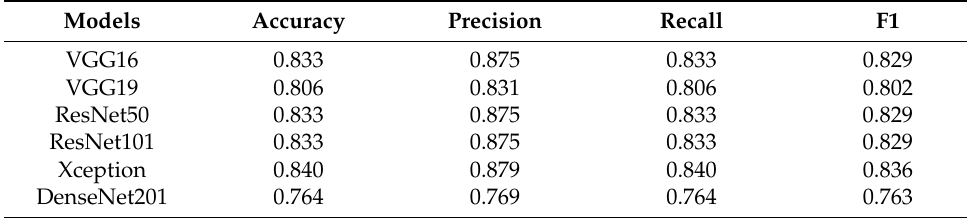
Table 4. The validation set results for six image feature classification models.